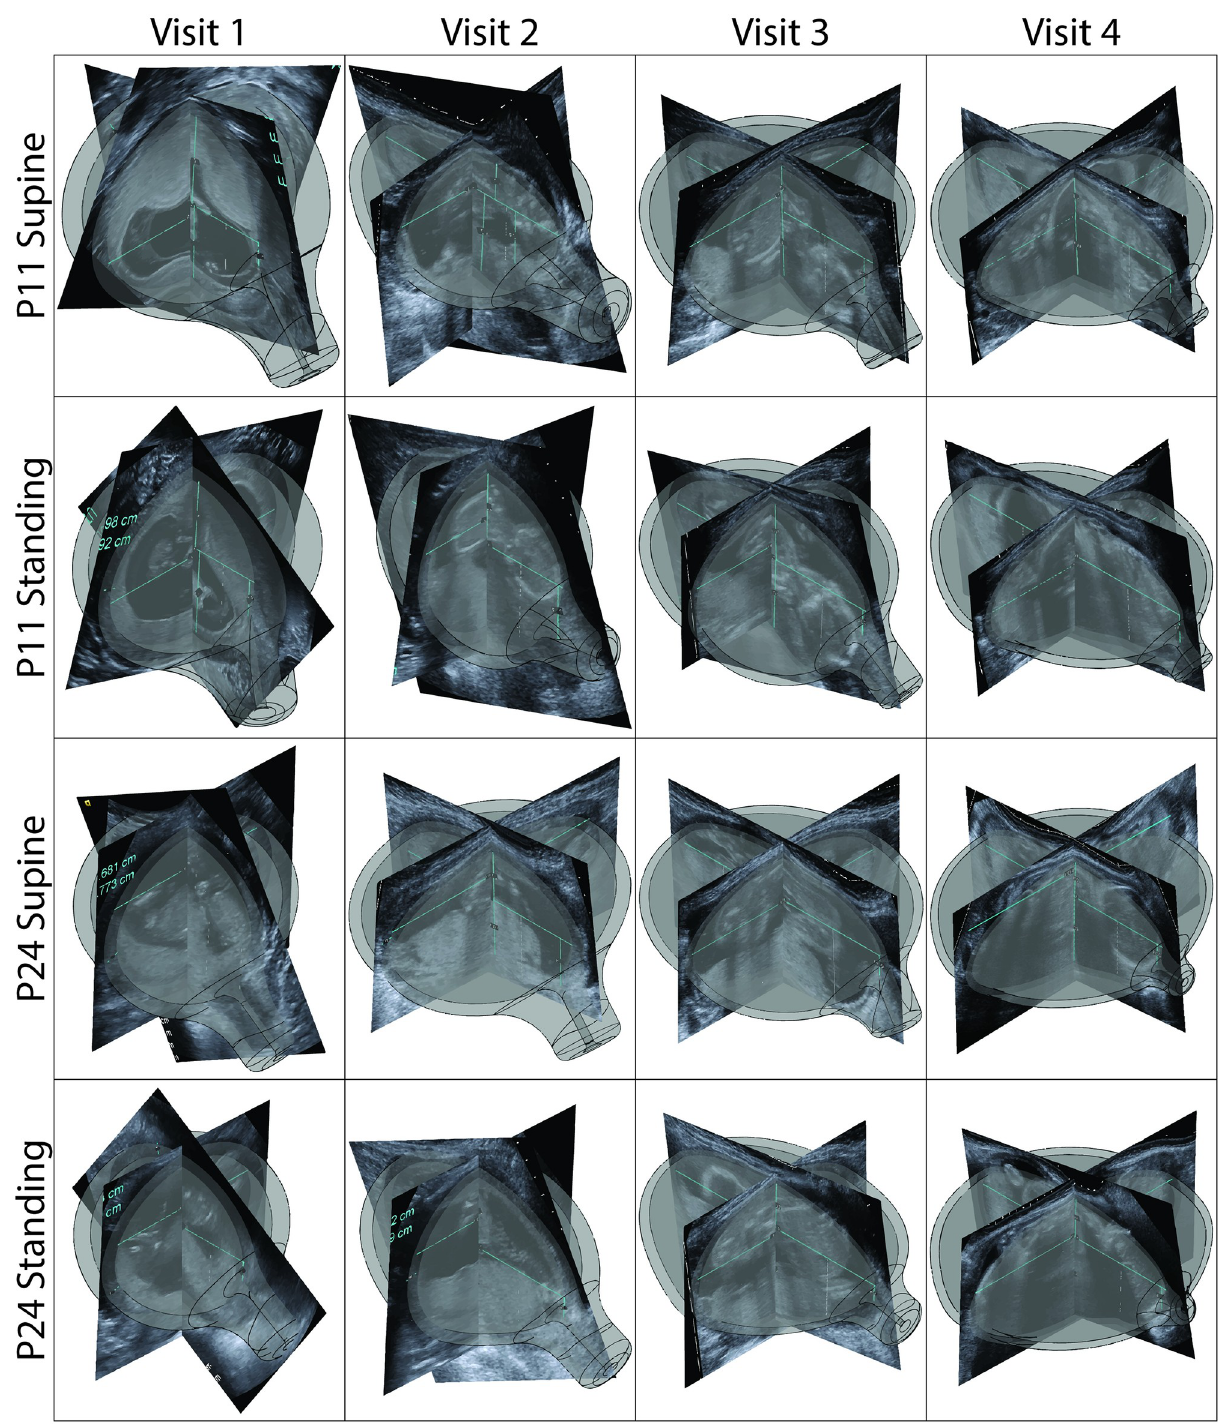
Fig 7. Representative overlays of Solidworks model and ultrasound for all visits. Solidworks models aligned with corresponding ultrasound scan along the inferior-superior intrauterine diameter (UD1) for (A) patient 11 in the supine position, (B) patient 11 in the standing position, (C) patient 27 in the supine position, and (D) patient 27 in the standing position for visits 1-4 (8w0d-13w6d, 14w0d-16w6d, 22w0d-24w6d, and 32w0d-34w6d gestation). Patients have been selected randomly from those where all models generated.